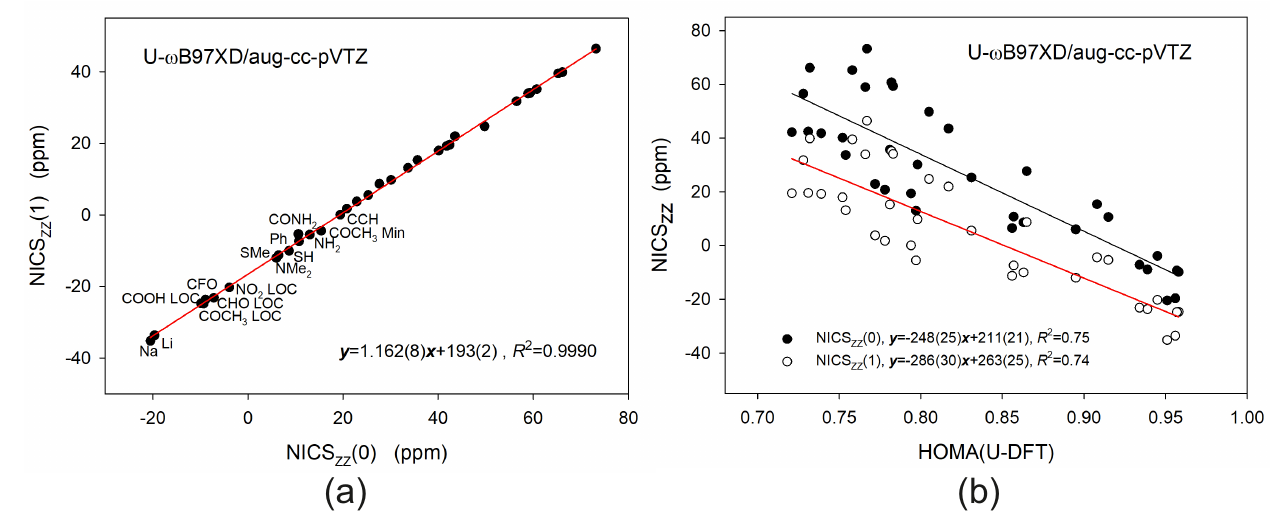
Figure 3. ( a ) Strong linear correlation between the NICS ZZ (1) and NICS ZZ (0) indices calculated for the monosubstituted benzene cation radicals. The forms with NICS ZZ (1) < 0 are explicitly signed. ( b ) Weak linear correlations between HOMA and NICS ZZ (1) and NICS ZZ (0) indices calculated for the monosubstituted benzene cation radicals. The calculations were performed at the U- ω B97XD/ aug-cc-pVTZ